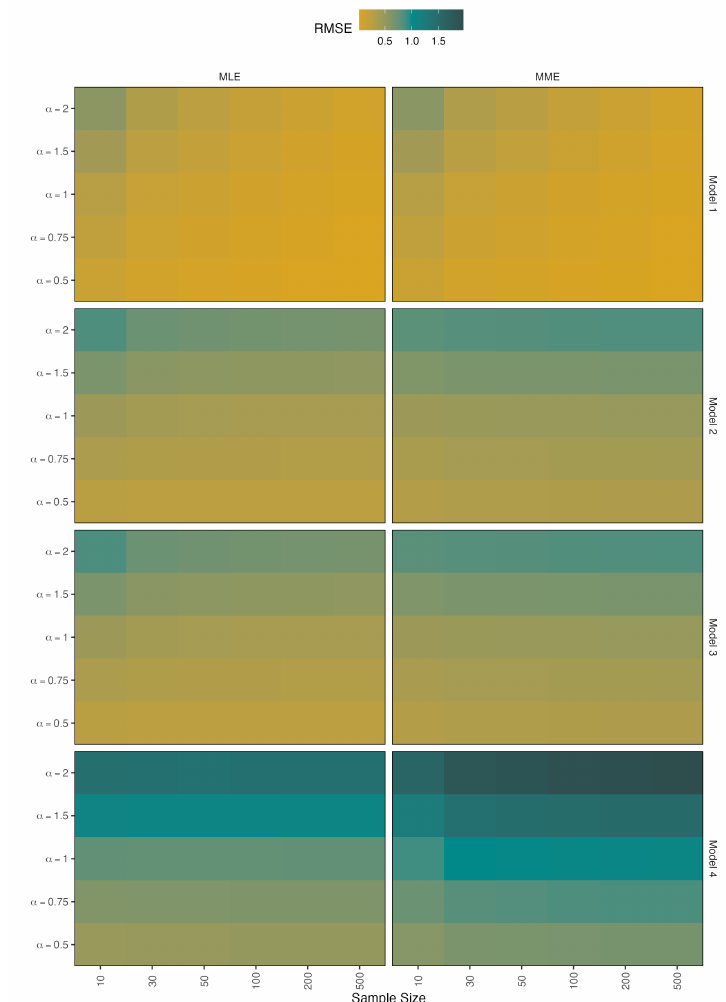
Figure 6. Simulated RMSEs for the estimators of α